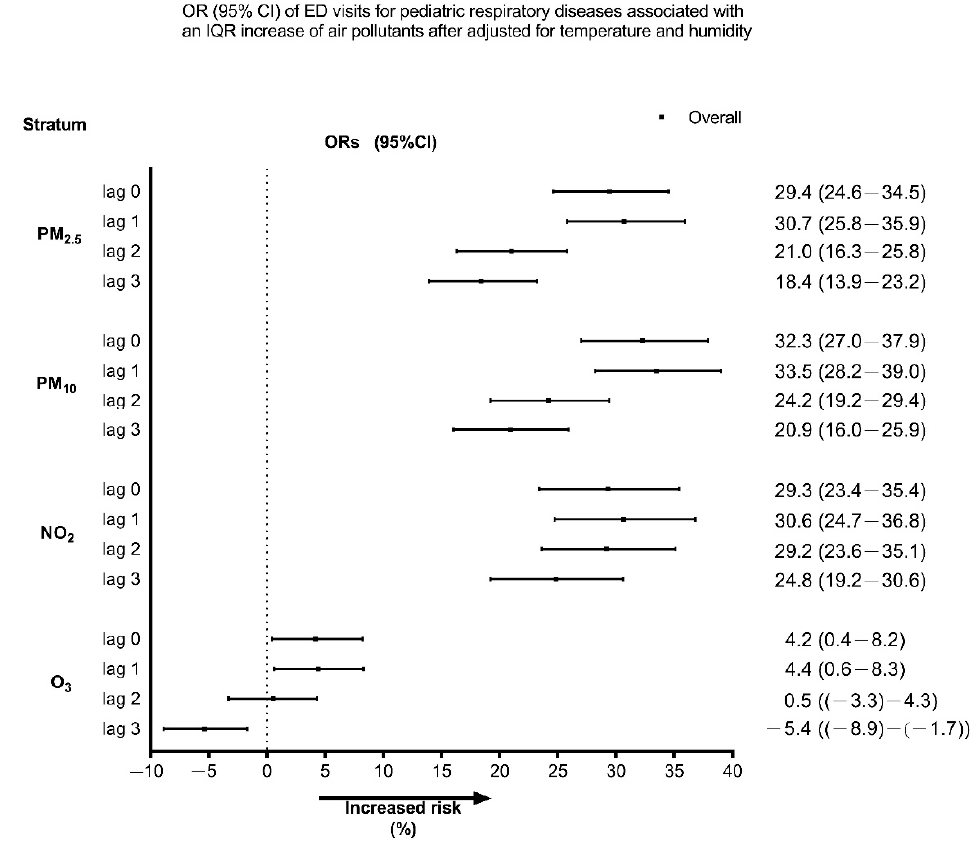
Figure 2. Odds ratios (ORs) and 95% confidence intervals (CIs) for pediatric respiratory disease- related ED visits associated with IQR increments in each air pollutant during the study period, with adjustments for temperature and humidity. ED, emergency department; IQR, interquartile range.